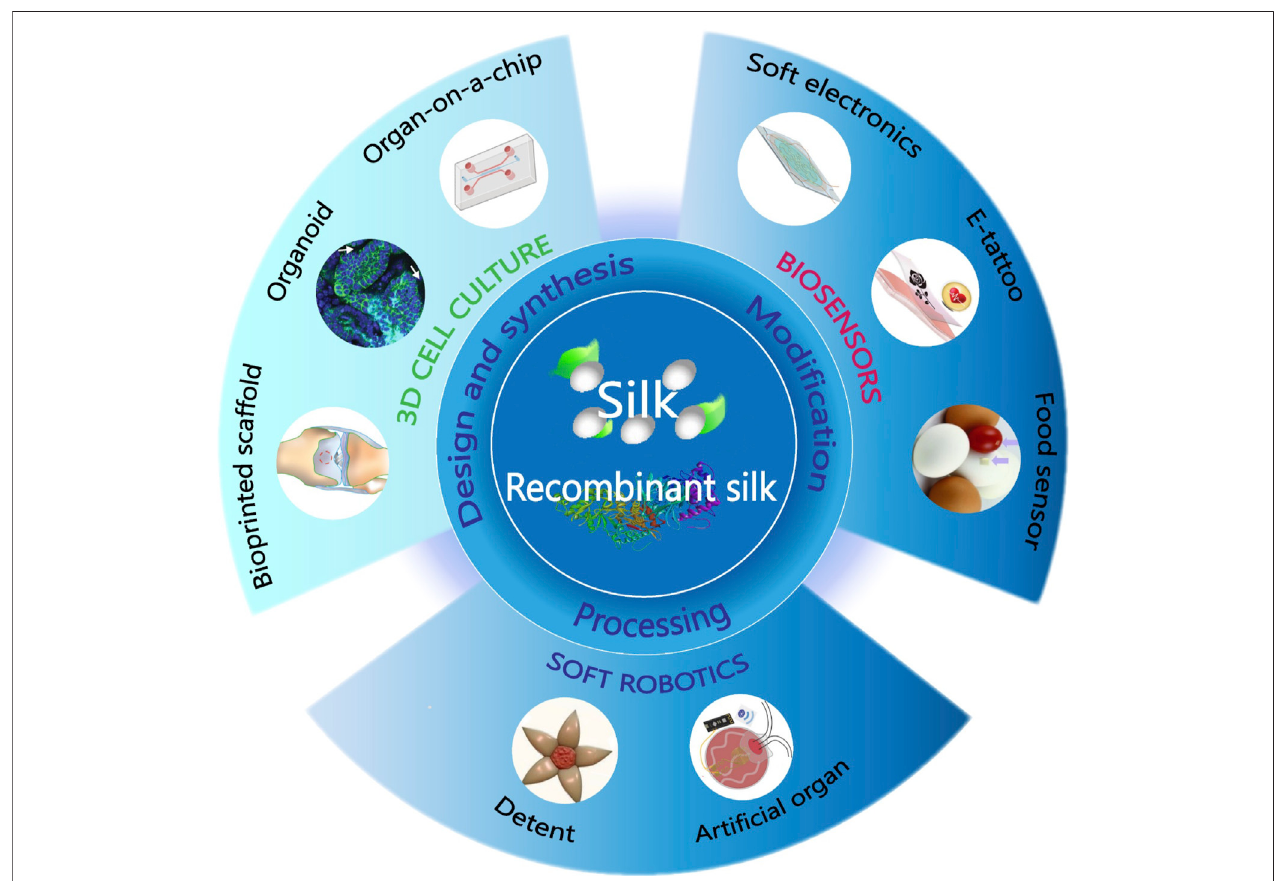
FIGURE 1 | Biodevices fabricated from natural and recombinant silk. Using innovative chemical modi fi cations and improved material processing techniques, the synthesized materials will be functionalized and fabricated into different forms and patterns for biodevice applications, including 3D cell culture, soft robotics, and biosensors. Adapted with permission from ref (Tao et al., 2012a; Yang et al., 2018; Wang Q. et al., 2019; Gupta et al., 2019; Wang Y. et al., 2020; Hayward et al., 2021; Yang et al., 2021). Copyright 2012 WILEY-VCH, 2018 WILEY-VCH, 2019 WILEY-VCH, 2020 National Academy of Sciences, 2021 American Chemical Society.